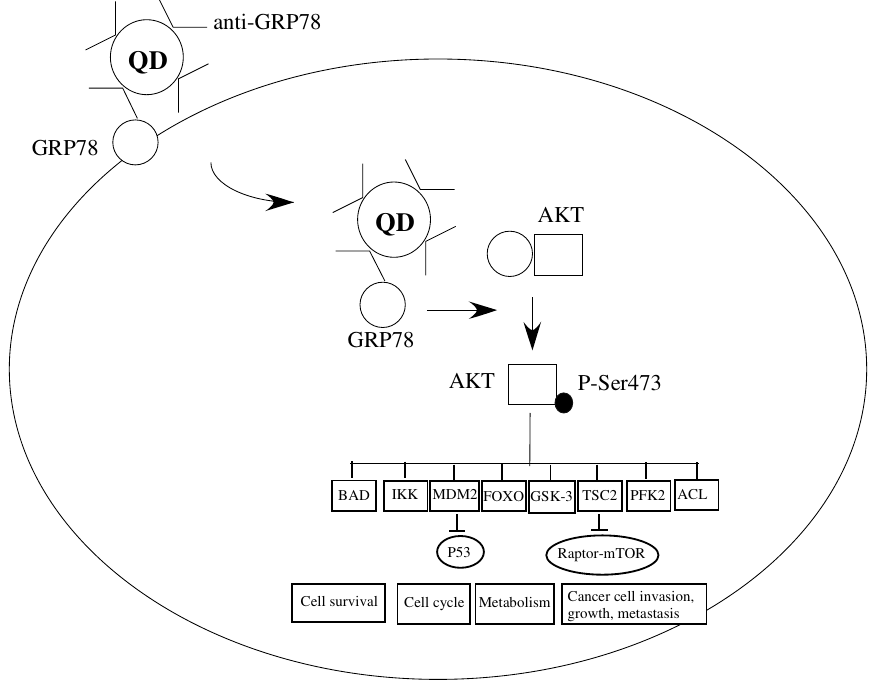
Figure 5. Schematic illustration of the Qdot-GRP78-scFv and GRP78 complex. The complex enters the intracellular space through GRP78 movement from cell into cytoplasm. The Qdot-GRP78-scFv:GRP78 complex prevents GRP78 binds to AKT, freeing AKT to cancer cell invasion and